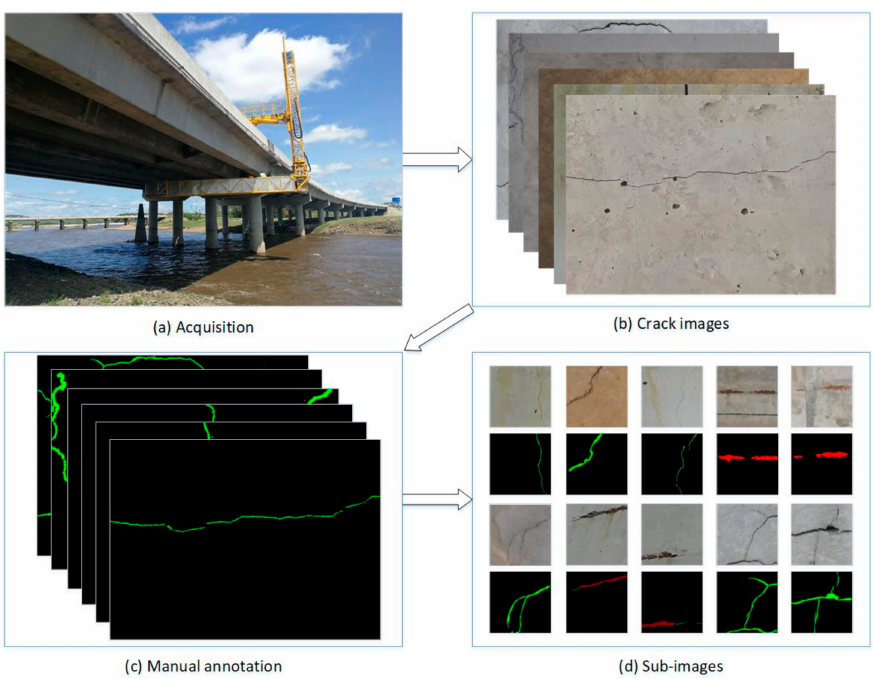
Figure 3. The establishment of bridge damage dataset consists of the following parts: ( a ) bridge image acquisition, ( b ) the captured bridge images, ( c ) manually marking the damage pixel area and ( d ) image clipping.